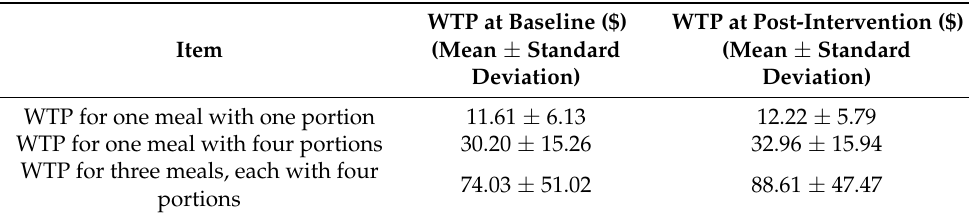
Table 3. Participant WTP for Meal Kits in General.